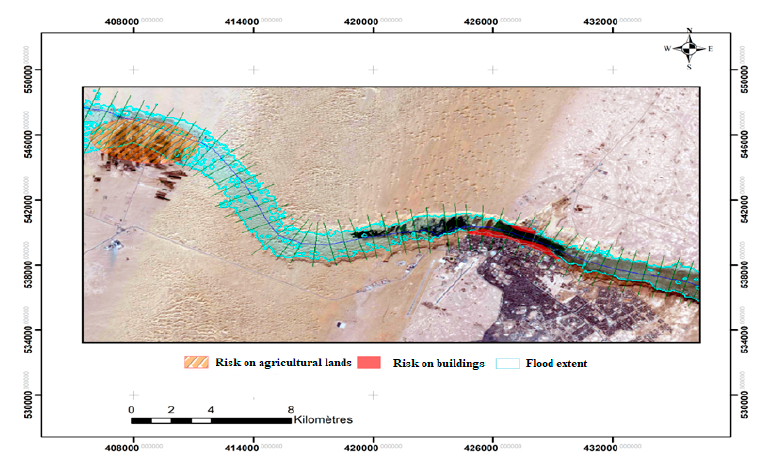
Figure 14. Hazard map of the study area.